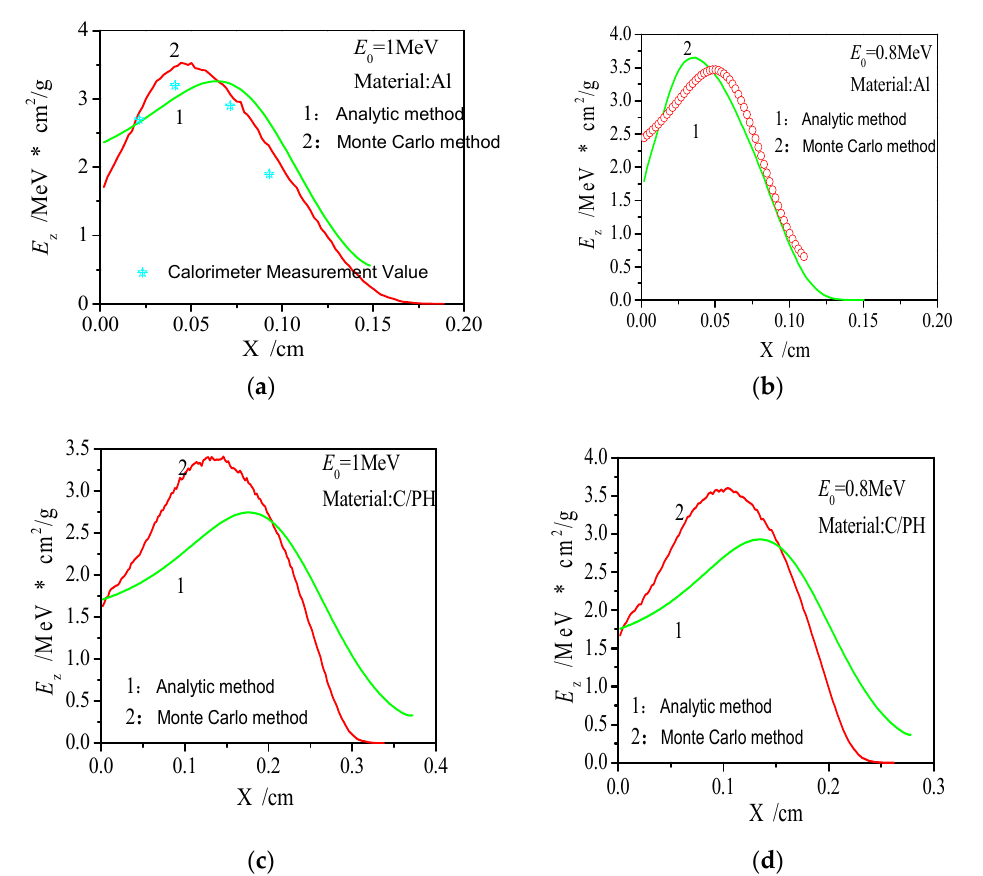
Figure 8. Comparison of the two calculation methods. ( a ) 1 Mev, Al. ( b ) 0.8 Mev, Al. ( c ) 1 Mev, C/PH. ( d ) 0.8 Mev, C/PH.